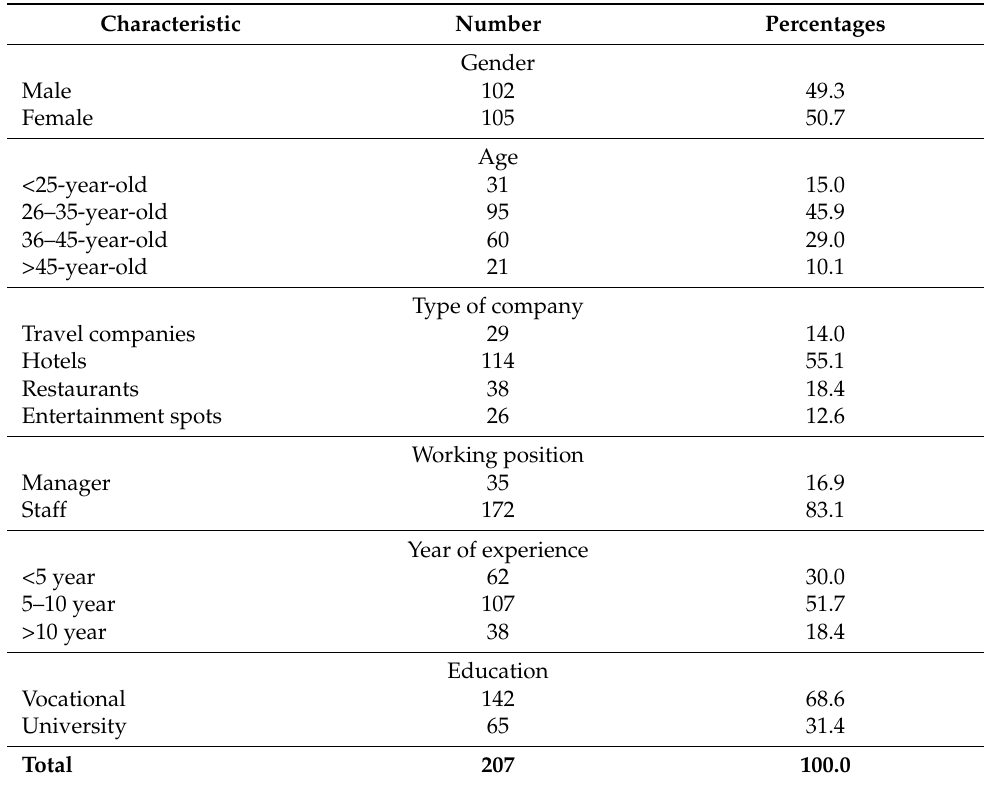
Table 2. Respondent background.